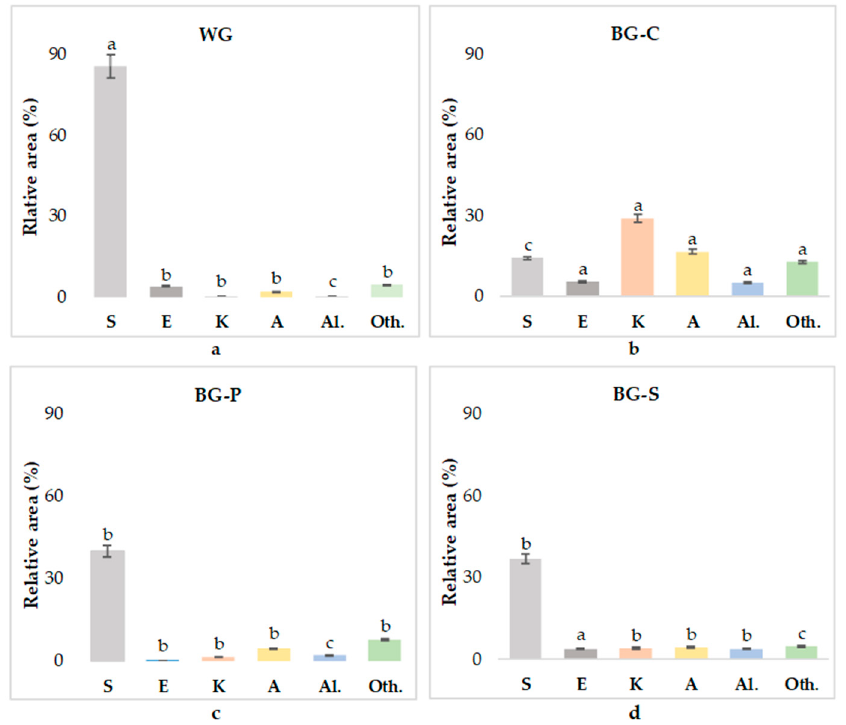
Figure 4. Relative area of peaks (%) for the MTX-G column of the main volatile compounds identified in the headspace of garlic samples. WG—white garlic ( a ), BG-C—black garlic cloves ( b ), BG-P—black garlic powder ( c ), BG-S—black garlic spread ( d ). Means ( n = 3) with different small letters (a–c) in the same chemistry family group are significantly different ( p < 0.05). S—sulfur compounds,